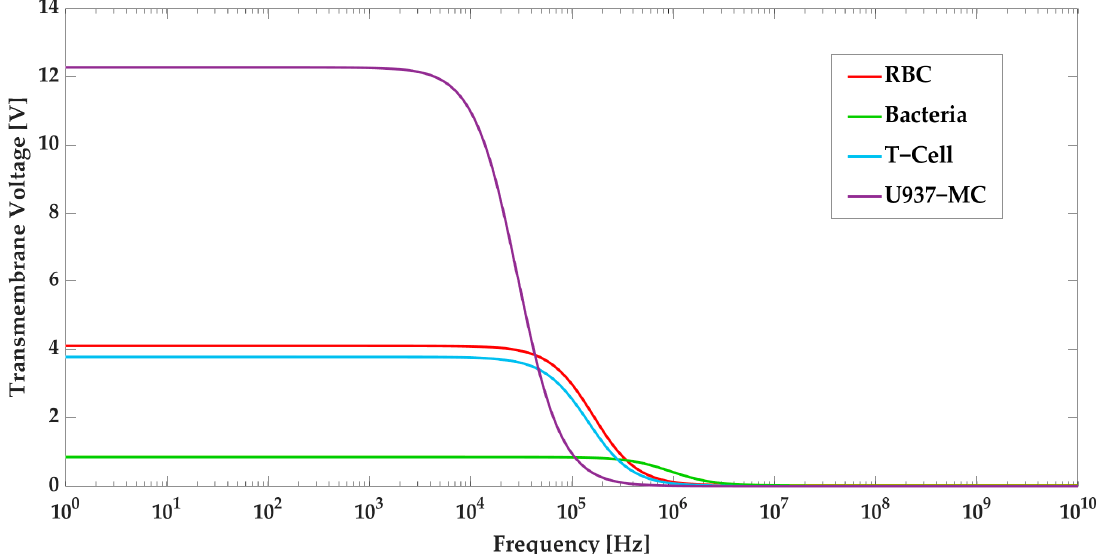
Figure 9. Transmembrane voltage for U937-MC, T-cells, RBCs, and bacteria as a function of fre- quency.